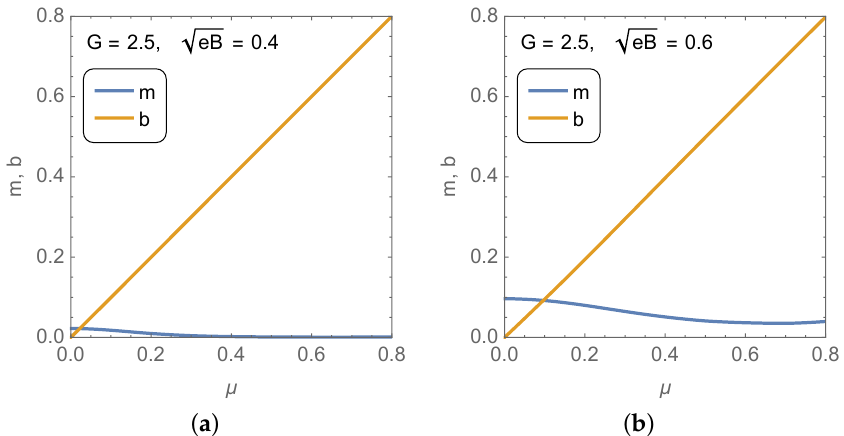
Figure 1. Solutions of the MDCDW gap equations versus the quark chemical potential at subcritical coupling ( G = 2.5) and magnetic fields ( a )